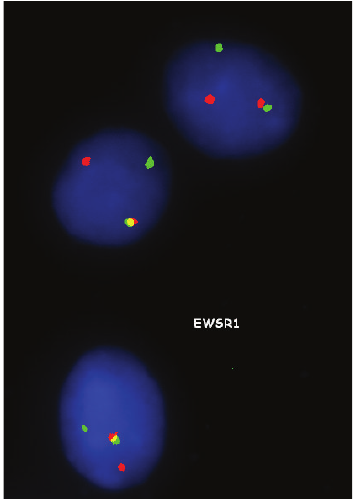
Figure 8: FISH study reveals the translocation involving EWSR1 gene at 22q12 with separate red and green signals compatible with Ewing sarcoma. As a side note, dual-color probes are located on either side of the EWSR1 gene and are normally seen as a single fusion signal.